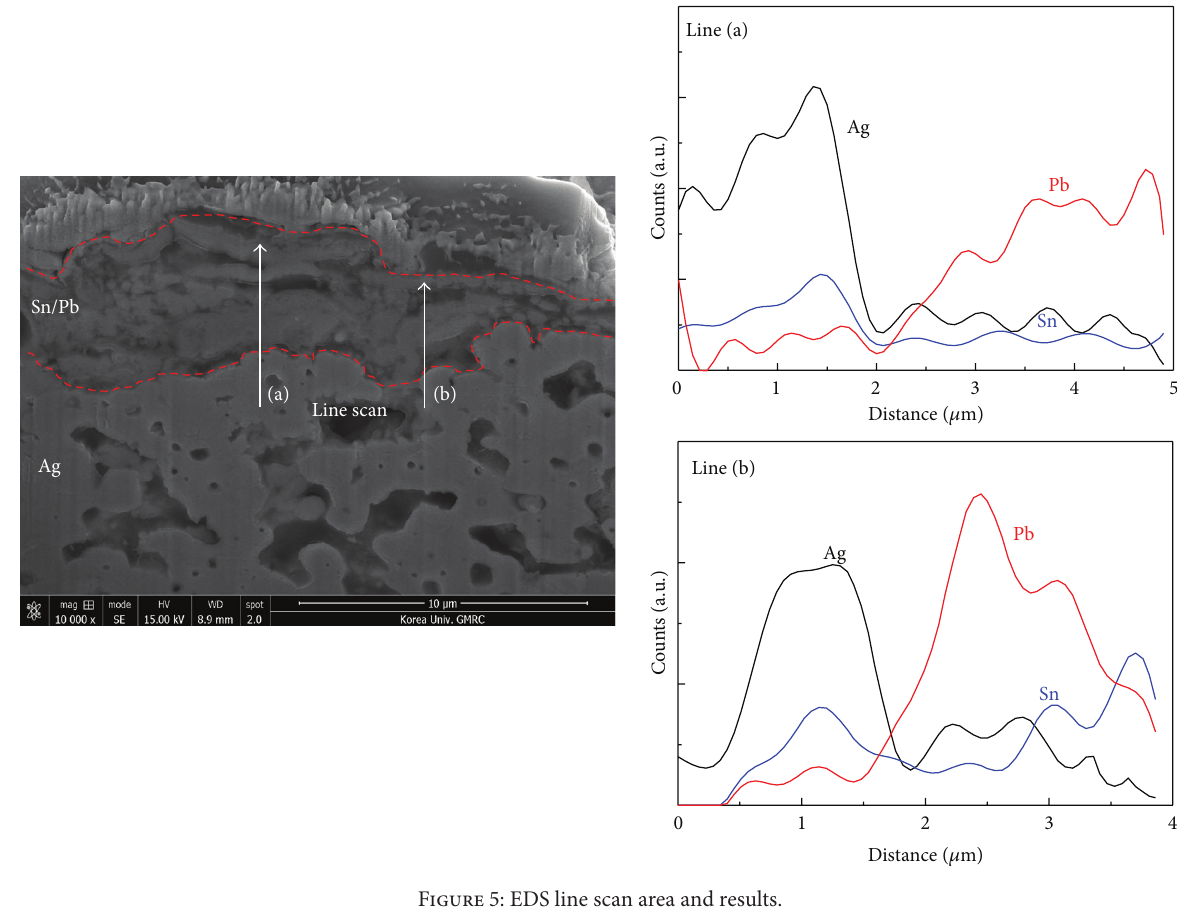
Figure 5: EDS line scan area and